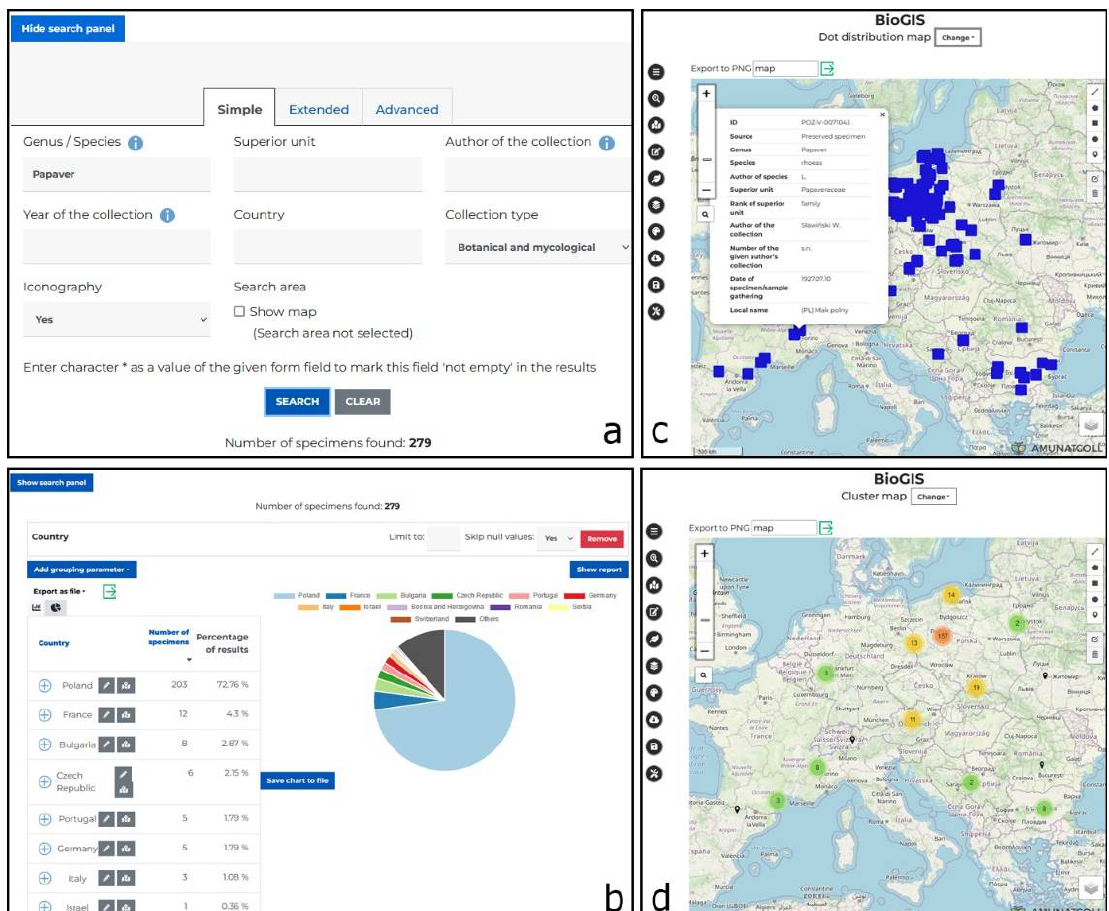
Figure 8. The use of statistical and spatial analysis tools available in the AMUNATCOLL panel: ( a ) searching for specimens according to selected criteria, ( b ) quantitative summaries of the search results in the form of tables and graphs, and ( c ) presentation of the results on maps.